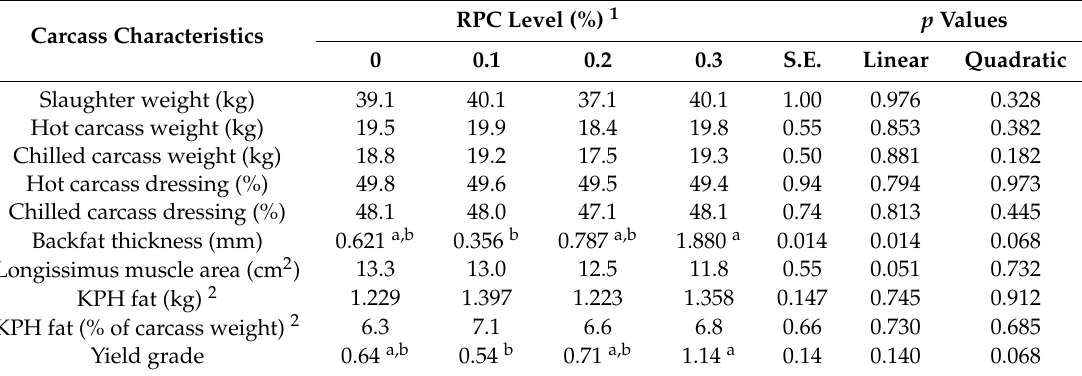
Table 4. Slaughter weight, and hot and chilled carcass dressing percentages, of lambs that were fed rations containing various RPC levels.